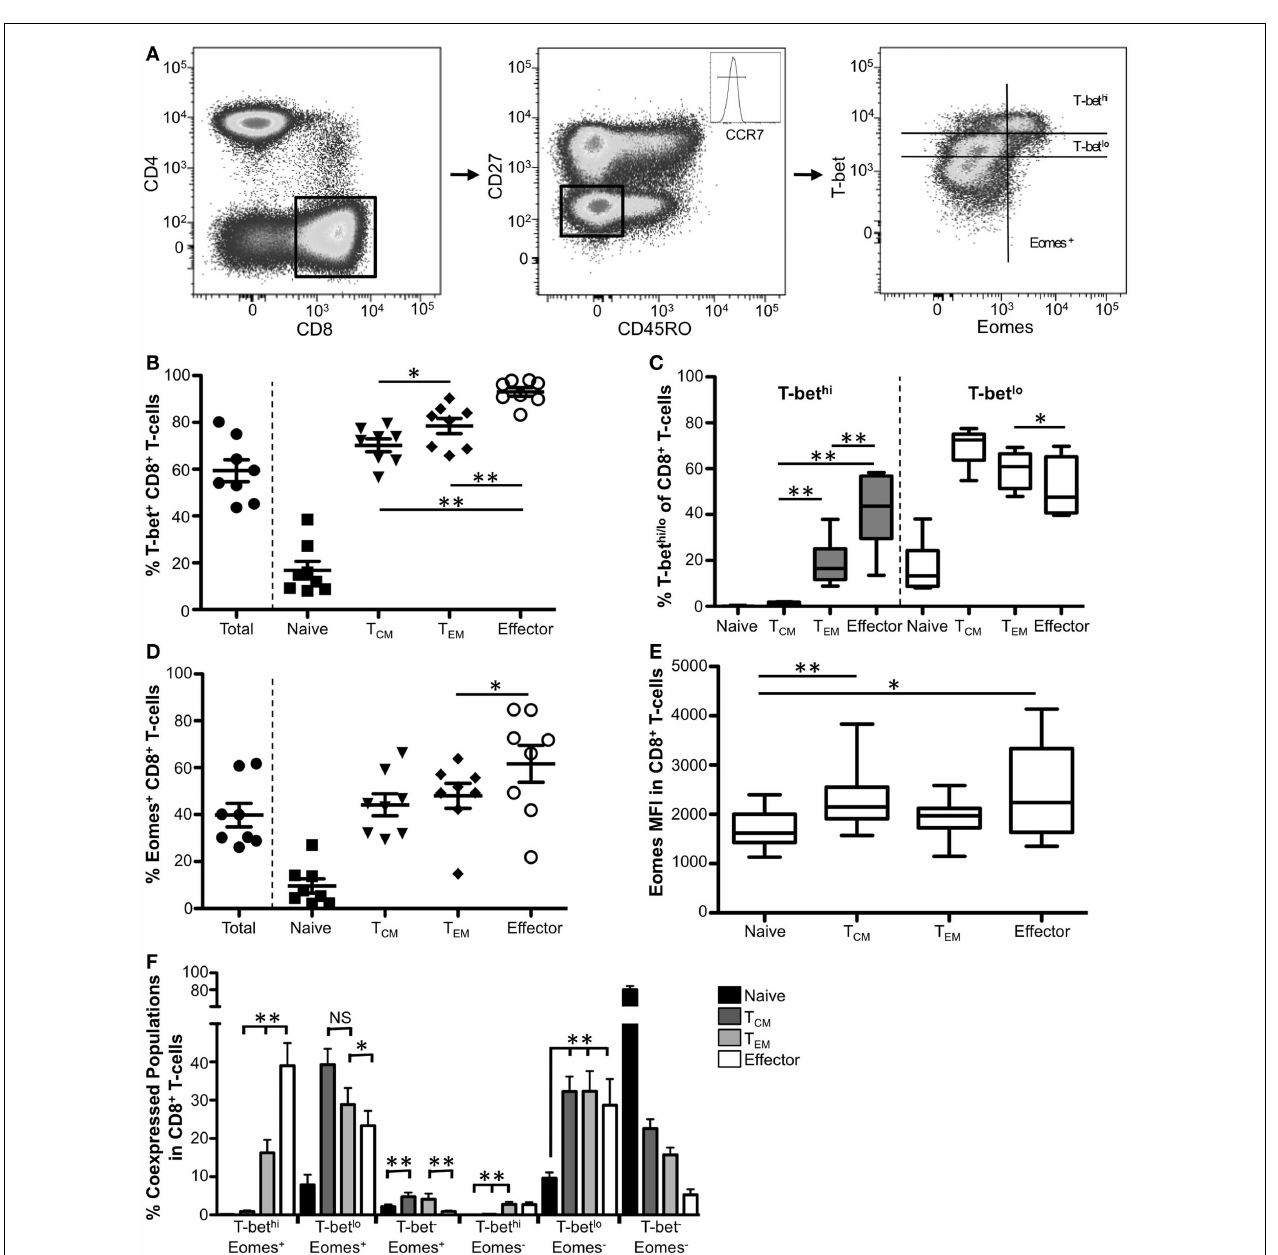
shown. Each symbol represents an individual donor. (C) Graphical representation of the mean frequency ofT-bet hi (gray) andT-bet lo (white) CD8 + T-cells is shown for each memory subset.The box and whisker graphs display 25–75% (box) and 10–90% (whisker).The line in the box represents the median value. (D) The frequency of CD8 + T-cells expressing Eomes is shown for each subset. (E) Median fluorescence intensity (MFI) is shown for Eomes within each subpopulation. (F) Co-expression ofT-bet and Eomes within each memory subset is shown. * p < 0.04, ** p <